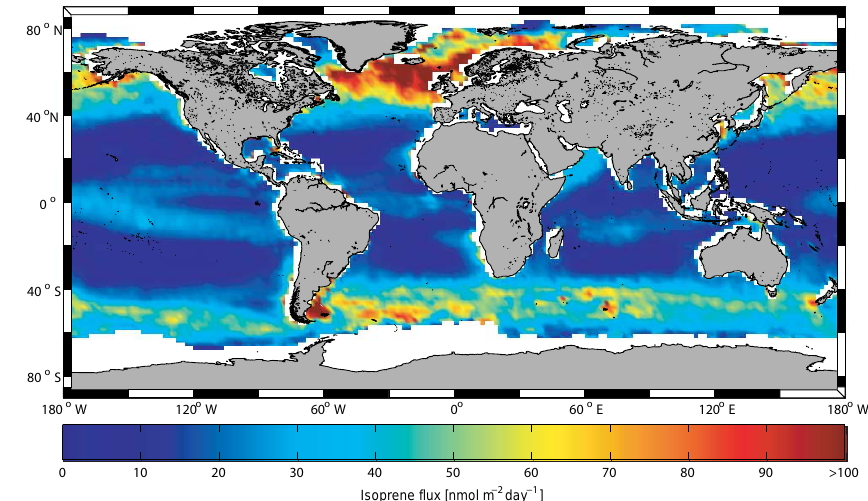
Figure 7. Global marine isoprene fluxes in nmolm − 2 day − 1 for 2014.